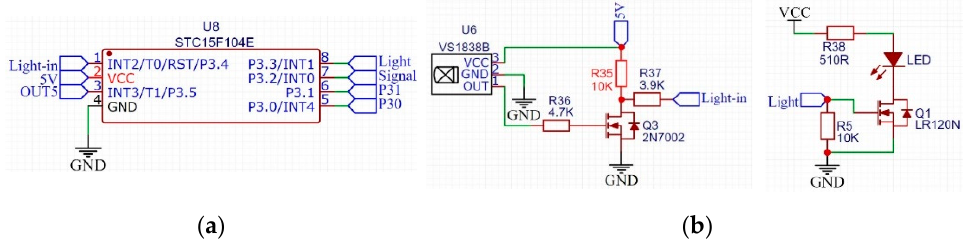
Figure 16. MCU and infrared communication circuit: ( a ) STC15 microcontroller circuit; ( b ) infrared communication circuit.